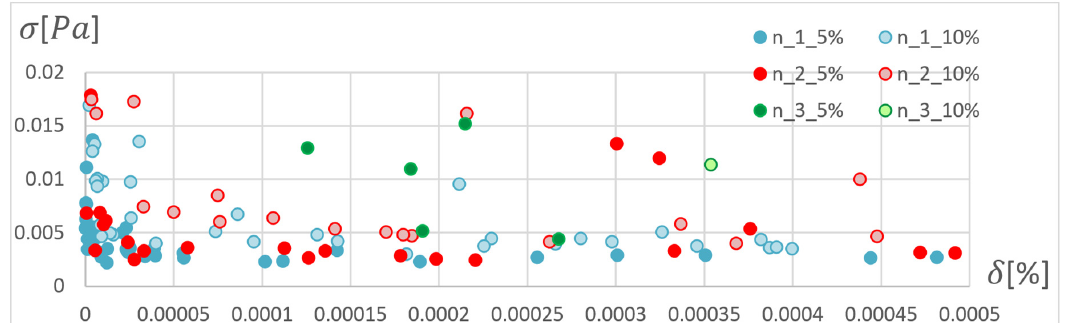
Figure 12. Pareto fronts for all networks trained using the SCG algorithm.